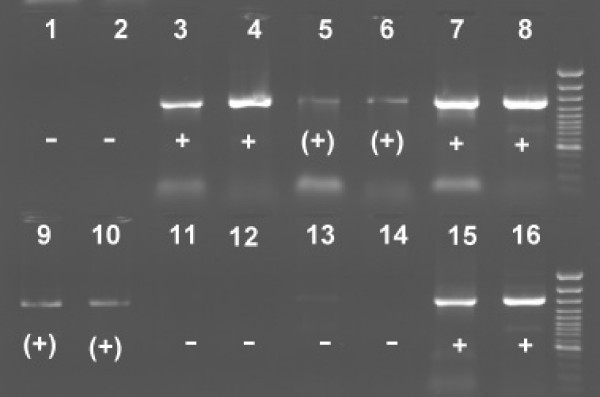
Agarose gel of PCR products from the Drosophila pseudolibrary. 5 μl samples of the PCR reactions were run on a 1.2% Agarose gel in 1 × TBE for 30 min. The DNA-bands were scored as indicated. Lanes: 1–8 Dicer 1 RNAse III; 9–16 Dicer 2 RNAse III; 1,13 Herculase 100 nM primers; 2,9,14 Phusion HF buffer, 100 nM primers; 3,15 Phusion HF buffer, 1 μM primers; 4,16 Phusion GC-TMSO buffer, 1 μM primers; 5 Pfu/Taq 1 μM primers; 6 Pfu/Taq-TMSO 1 μM primers; 7 Herculase 1 μM primers; 8 Herculase-TMSO 1 μM; 10 Phusion GC-TMSO buffer, 100 nM primers; 11 Pfu/Taq 100 nM primers; 12 Pfu/Taq-TMSO 100 nM primers. HF- and GC-buffers are intended to favor high-fidelity PCR of templates with low or high GC-content, respectively. Markers: 100 bp DNA ladder Plus (Fermentas), top band 3000 bp, strong band 500 bp.